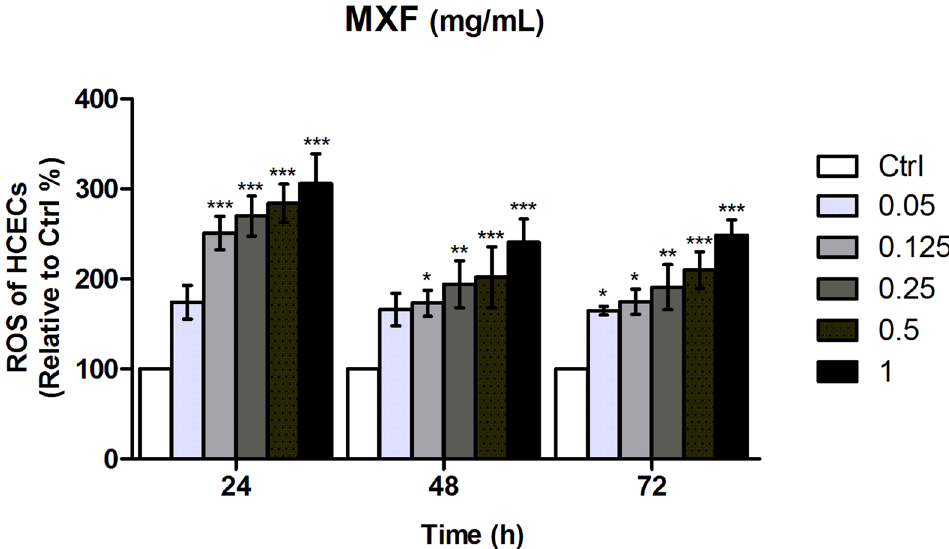
Figure 2. Induced reactive oxygen species (ROS) in HCECs after exposure to different concentrations of MXF for 24 h, 48 h, and 72 h. MXF increased cellular ROS generation dose dependently. Even the low concentrations of MXF (0.05 mg/ml and 0.125 mg/ml) induced significant ROS increase. The triplicates of each treatment group were used in each independent experiment. The values were given as the mean ± SEM from three independent experiments. P values were calculated compared with negative control. Ctrl: no treated normal control. * p < 0.05; ** p < 0.01; *** p <